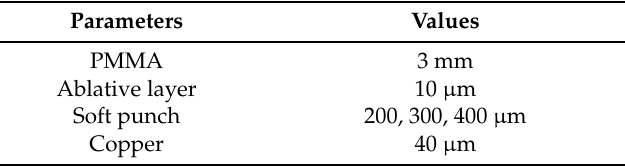
Table 2. The thicknesses of the experimental